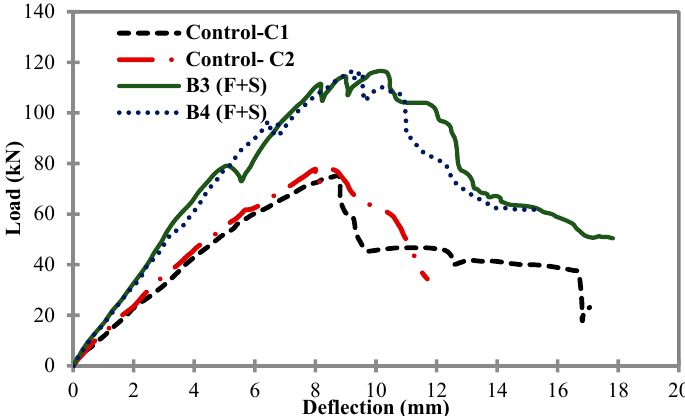
Figure 7. Load vs mid-span deflection for control samples C1 and C2, B3 and B4. Figure 7. Load vs. mid-span deflection for control samples C1 and C2, B3 and